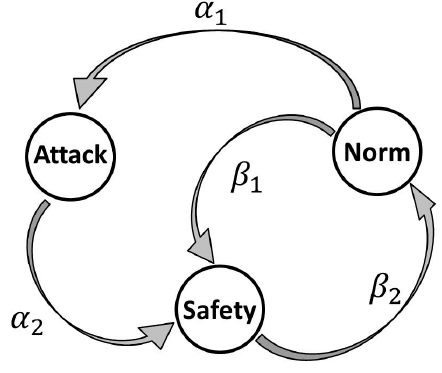
Figure 3. State diagram of sensor modes.